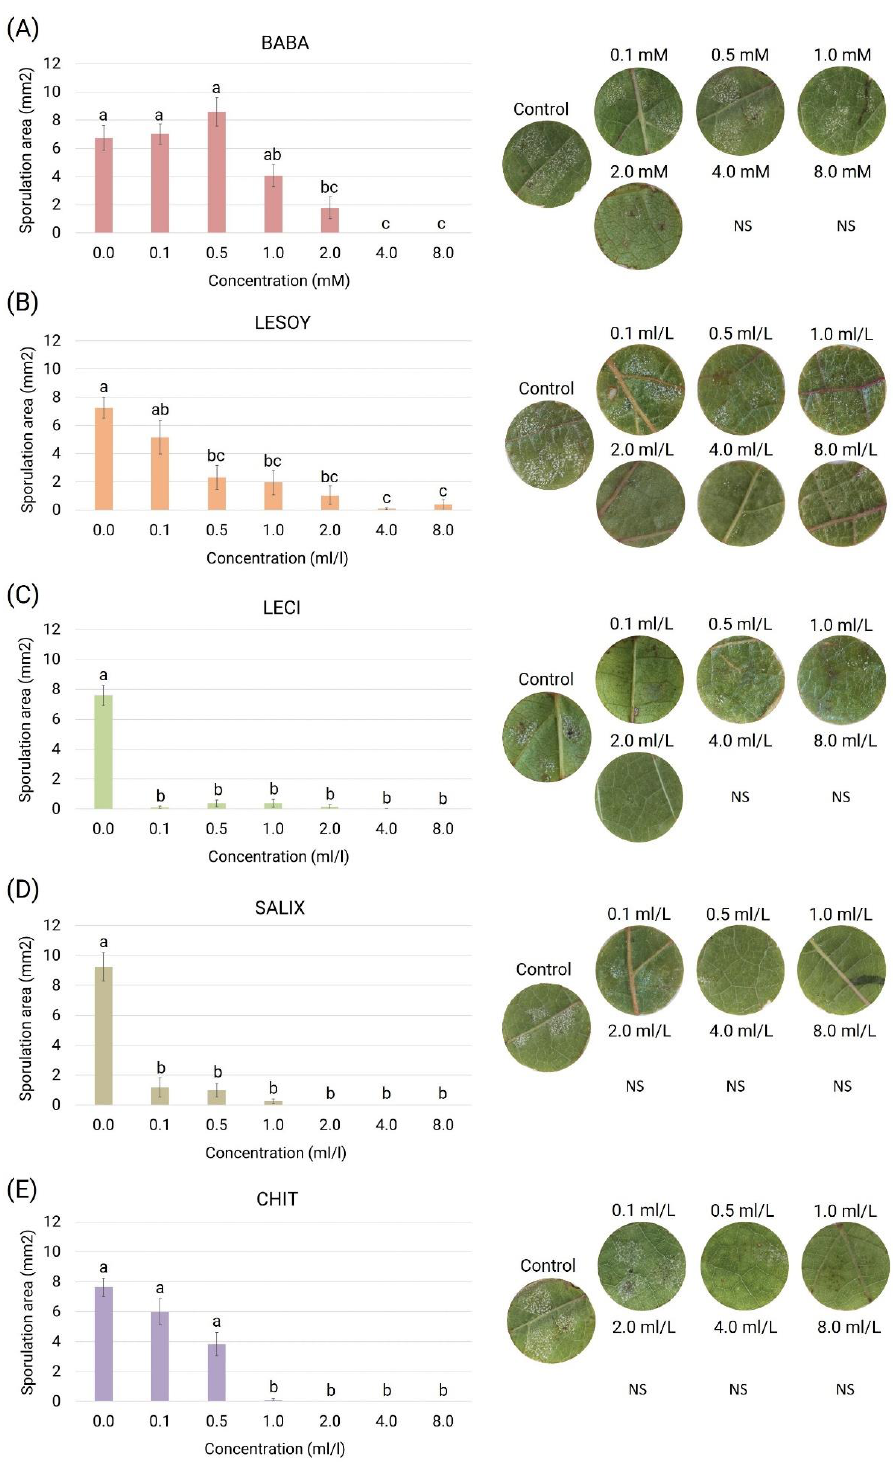
Figure 3. P. viticola sporangia mixed with different concentrations of the products showed a decrease in the pathogen mean sporulation area as the concentration increased. Representative photos of leaf discs are displayed seven days after infection for each product and concentration. ( A ) BABA, ( B ) LESOY, ( C ) LECI, ( D ) SALIX, and ( E ) CHIT. A Dunn’s post hoc test (α = 0.05) was performed for each product in order to find statistical differences between concentrations, which are denoted by different small letters in the bar graphs. No sporulation